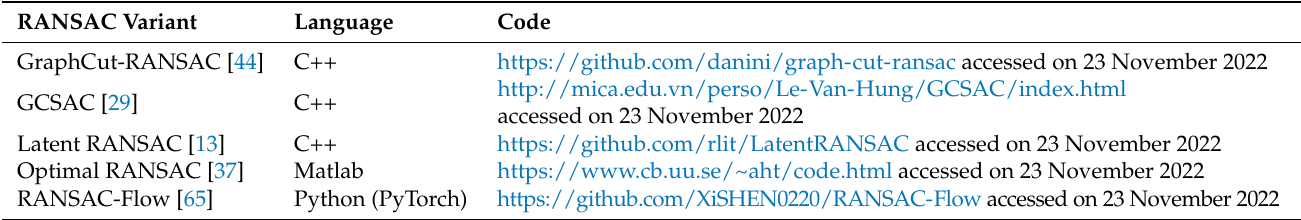
Table 4. Software implementations of RANSAC variants.